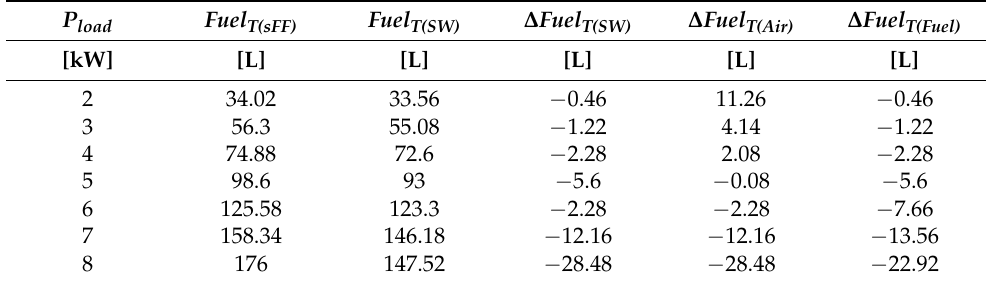
Table 1. Fuel economy for k fuel = 0.